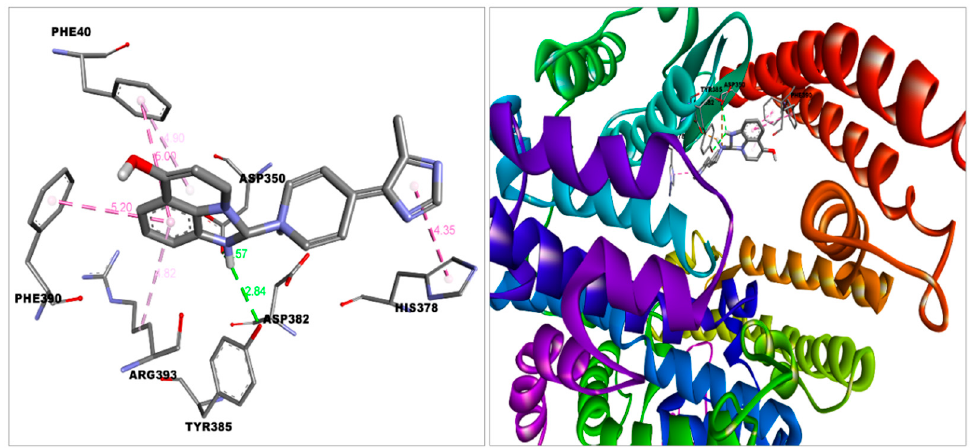
Figure 3. Docking of imidazoquinolinone in the binding pocket of ACE2.Discovery Studio Visualizer was used to create this figure. (http://accelrys.com/products/collaborative-science/biovia-discovery-studio/visualization-download.php).